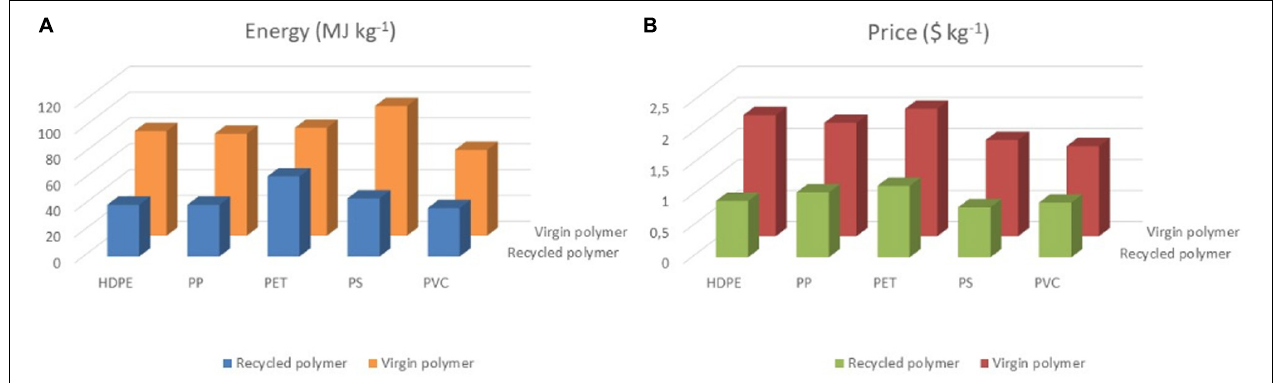
FIGURE 11 | (A) Energies and (B) prices of virgin and recycled polymers. HDPE, high-density polyethylene; PP, polypropylene; PET, polyethylene terephthalate; PS, polystyrene; PVC, polyvinyl chloride.